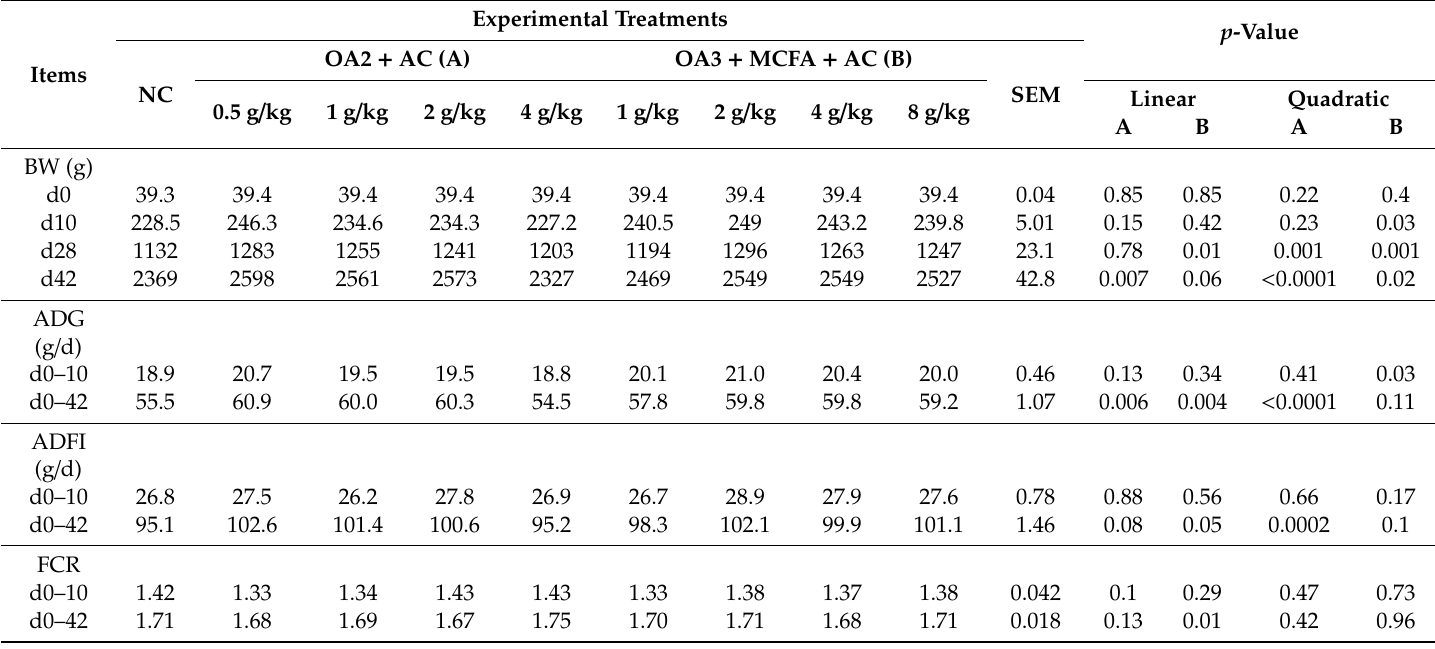
Table 4. E ff ect of dietary treatments on productive performance of chickens during the di ff erent phases and the entire experimental period (Trial